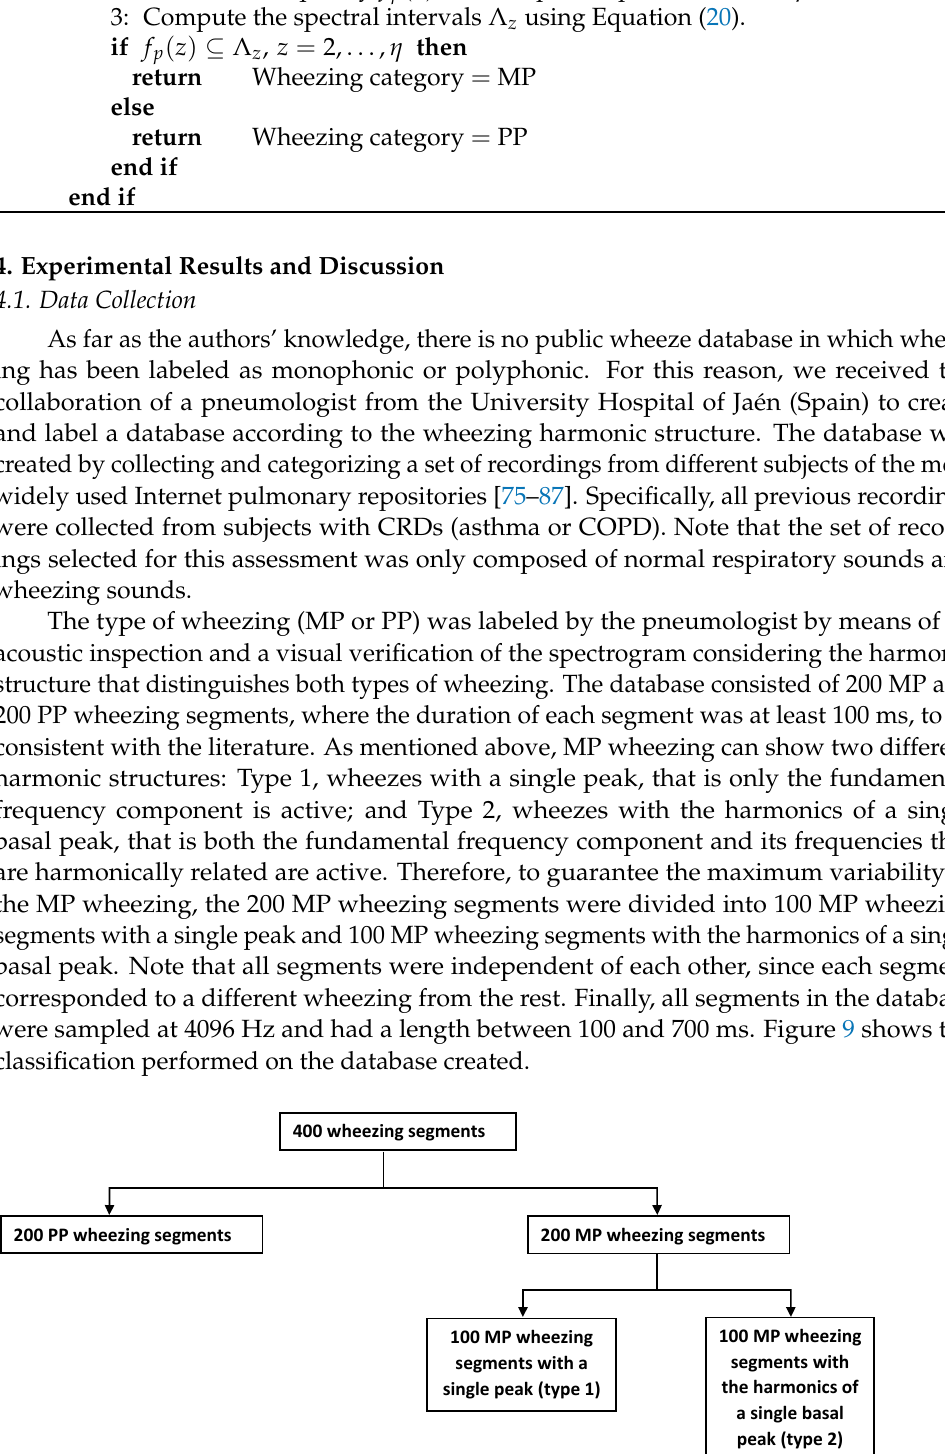
Figure 9. Scheme of the types of wheezing contained in the